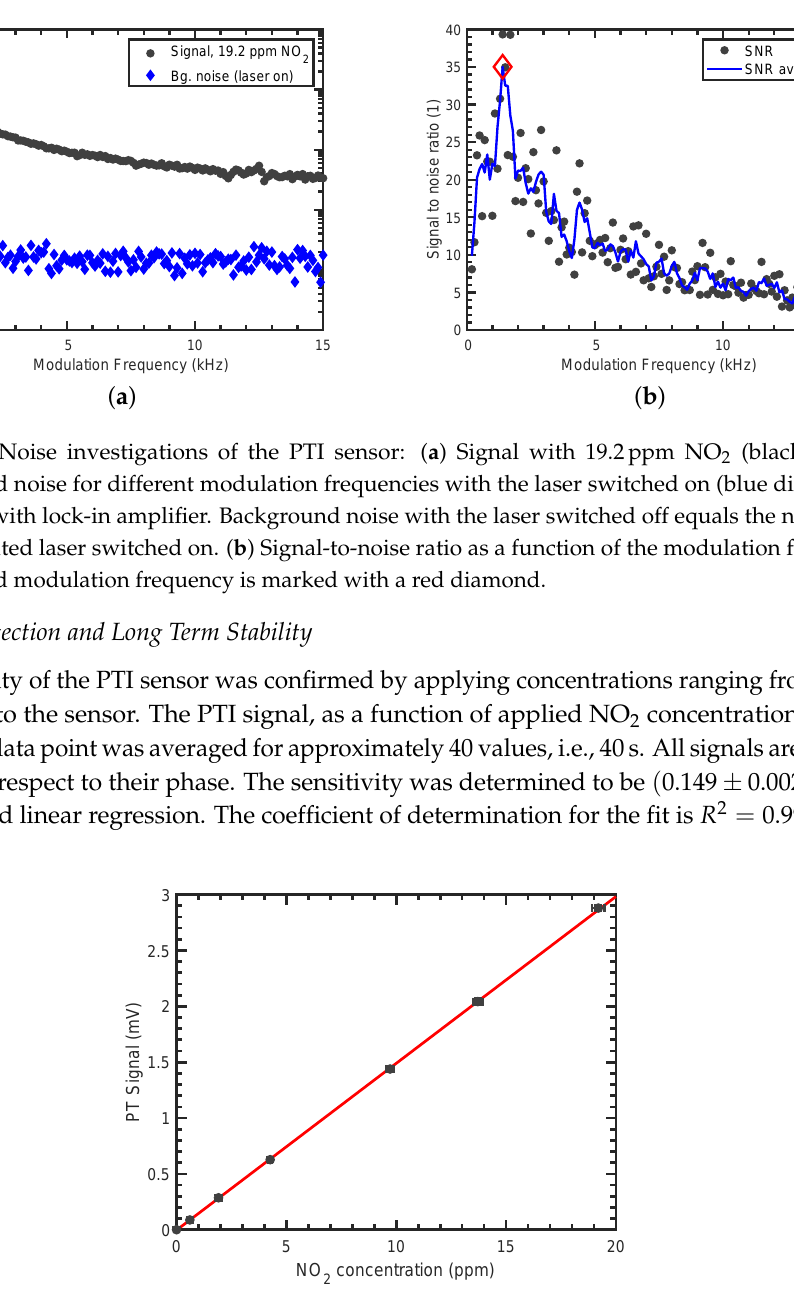
Figure 6. Linear fit (red) of the background-corrected photothermal signal as a function of the NO 2 concentration. Error bars of the photothermal signals are the standard deviation relative to the mean. Error bars of the concentrations are too small to be visible on this